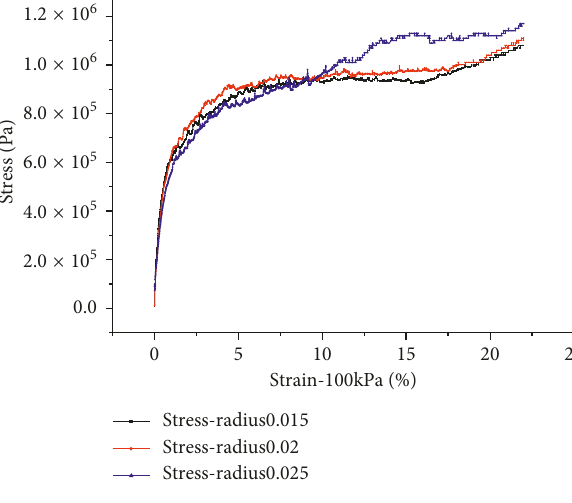
Figure 9: Stress-strain of different particle radii.